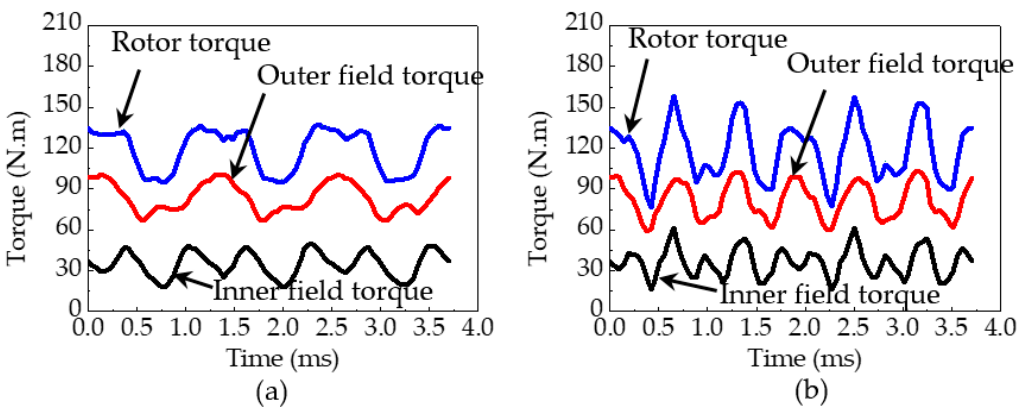
Figure 12. Torque contribution for the output rotor torque in the inner field and the outer field: ( a ) When the output rotor operates at 1246 rpm ( f inner = 270 Hz, f outer = 0 Hz); ( b ) When the output rotor operates at 2492 rpm ( f inner = 270 Hz, f outer = 270 Hz).